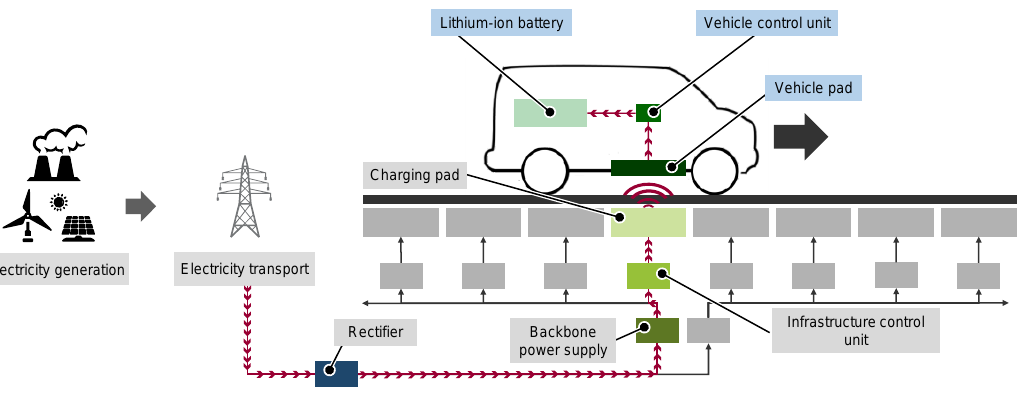
Figure 2. Components of IPTEV powertrains [6].